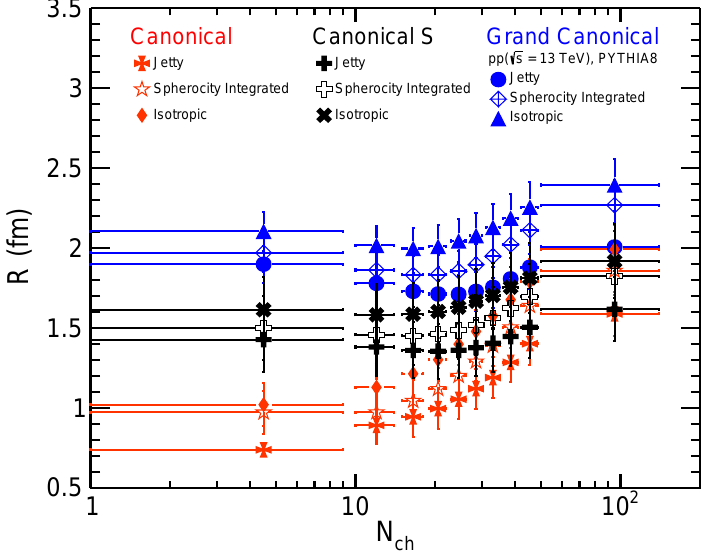
Figure 6. The extracted freeze-out radius as a function of different spherocity classes (shown by different markers) and charged particle multiplicity ( N ch ) for the canonical, strangeness (S) canonical, and grand canonical ensembles. The red and black points are obtained using the canonical ensemble and the strangeness canonical ensemble, respectively, whereas the blue points are for the grand canonical